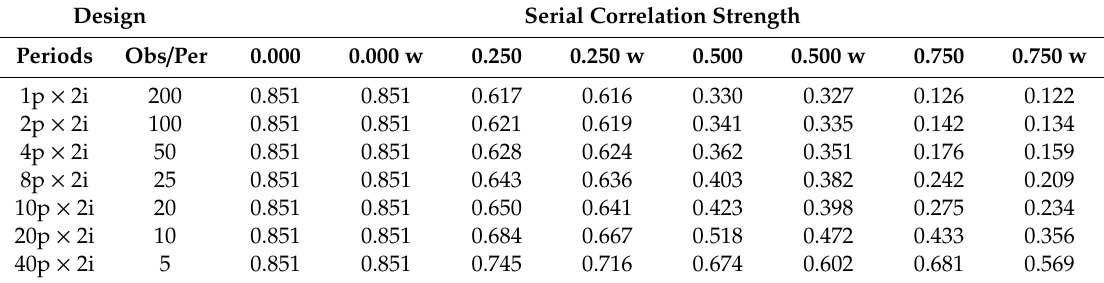
Table 1. The e ff ect of serial correlation and intervention period stacking with and without washout periods on the power to detect a mean di ff erence of 0.30 standard deviation units between two interventions with 400 total observations based on the proposed analytical model. A type I error rate of 0.05 was